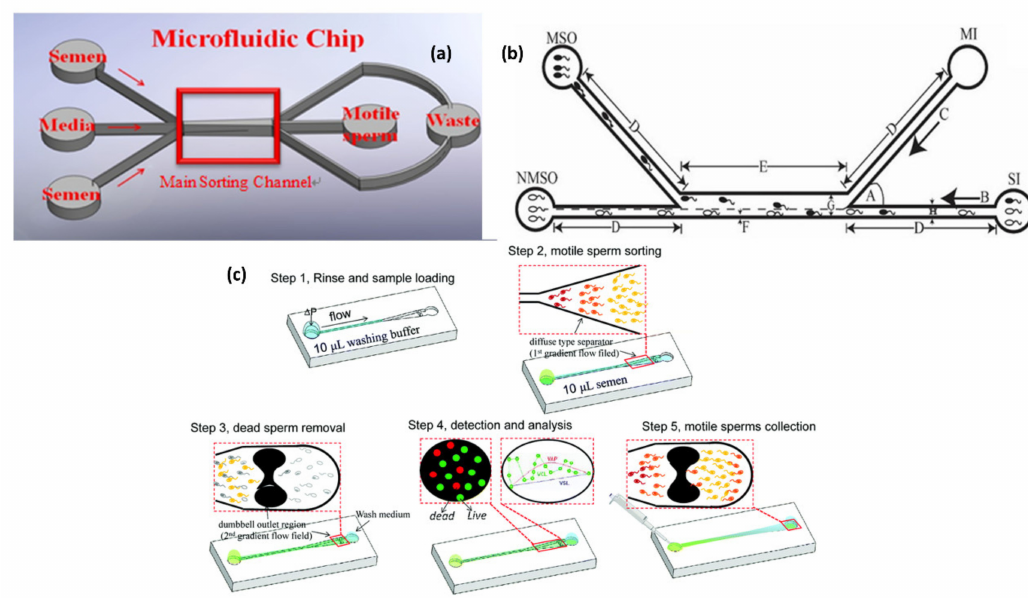
Figure 2. Different microfluidic devices for motile sperm sorting. ( a ) is adapted from ref. [61] with permission from Springer Nature, ( b ) is adapted from ref. [62] with permission from Springer Nature and ( c ) is adapted from ref. [63] with permission from Springer Nature and from the Royal Society of